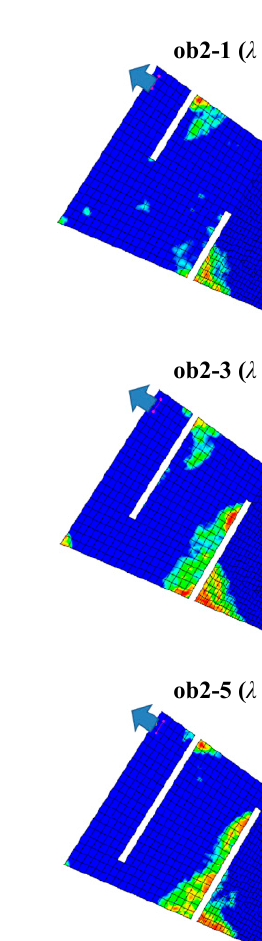
the white rectangular bars represent the baffles. The hydraulic efficiency is shown in parentheses according to the name of each scenario.